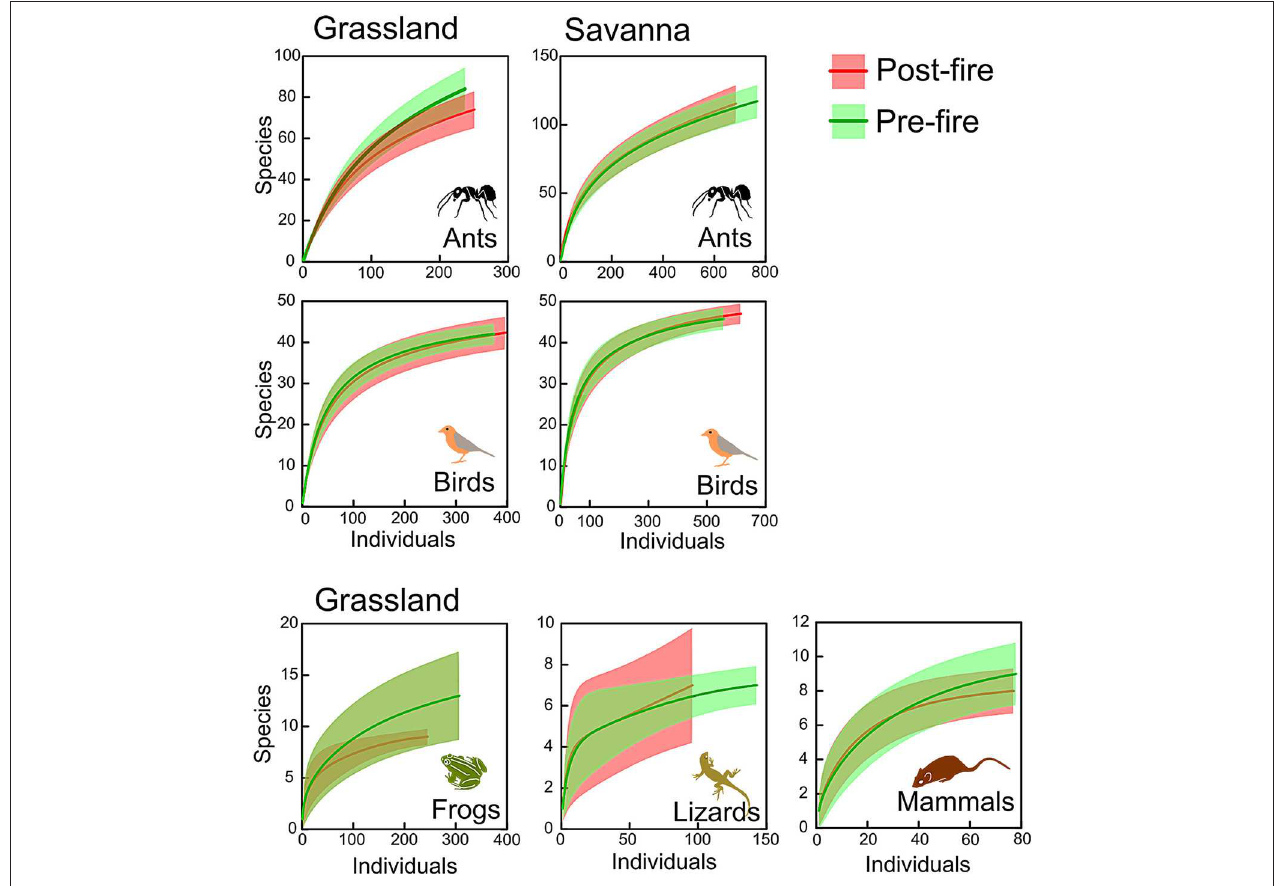
FIGURE 2 | Individual-based rarefaction curves (with 95% confidence intervals) comparing species richness of different animal groups between the unburned (green) and burned areas (red) in grassland and savanna vegetation types, at Santa Bárbara Ecological Station, state of São Paulo, Brazil.